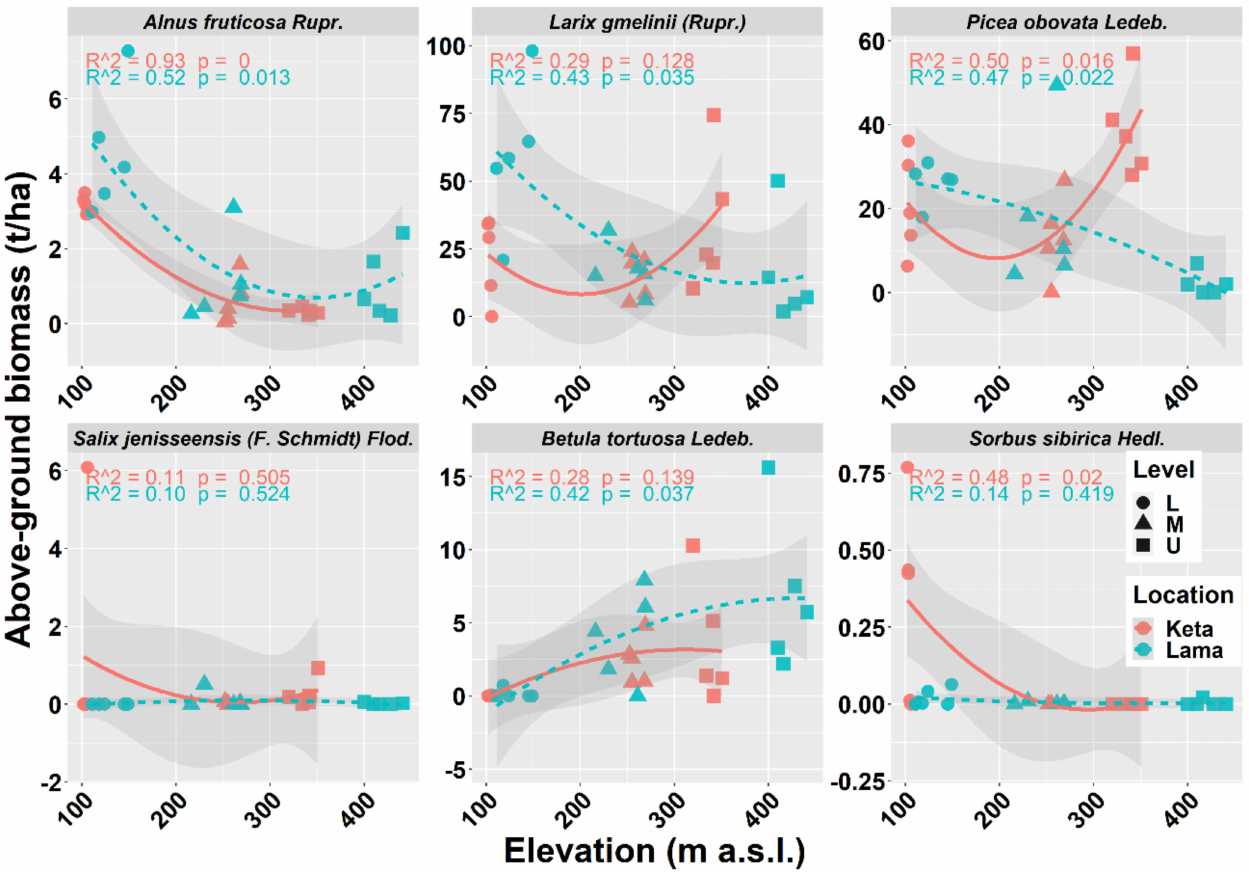
Figure 4. Relationship between elevation and aboveground living tree biomass of individual tree species at two locations. Points represent biomass values at individual sample plots. Lines represent fitted non-linear models, and grey areas show 95% confidence intervals around the fitted models. Level: L—lower elevational zone, M—middle elevational zone, U—upper elevational